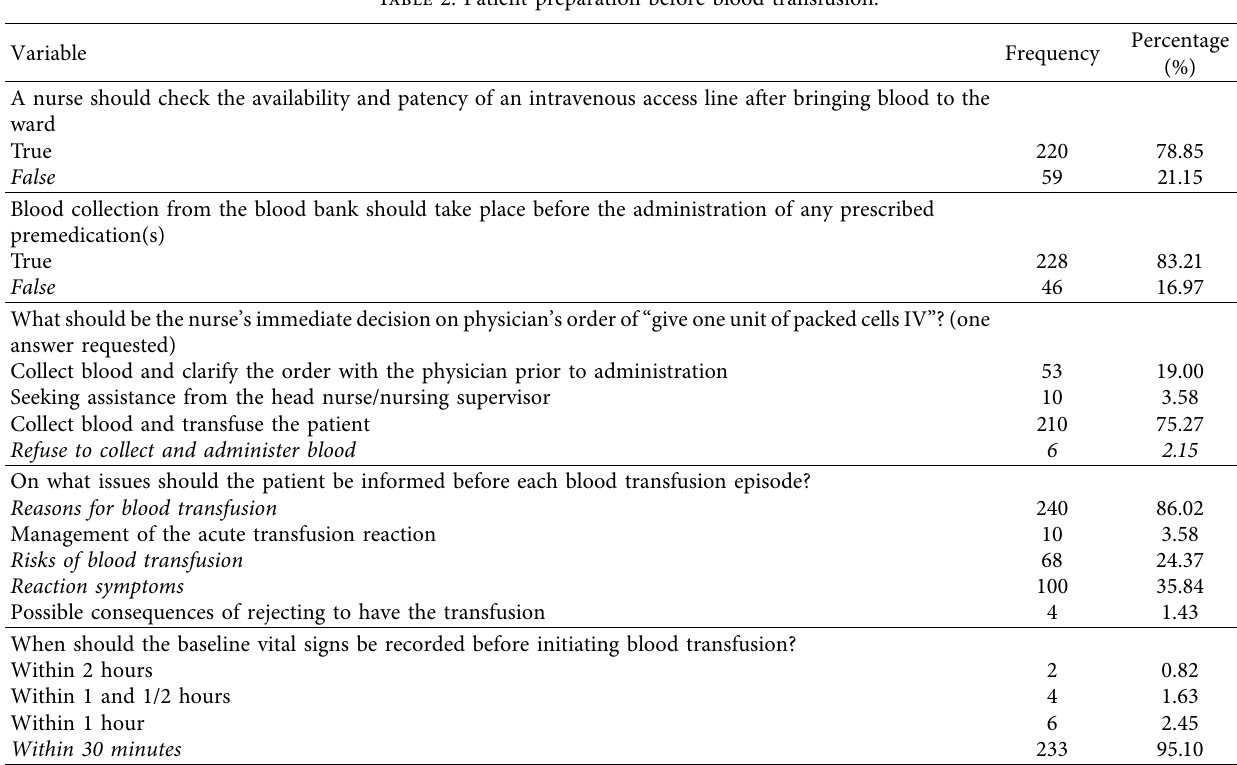
Table 2: Patient preparation before blood